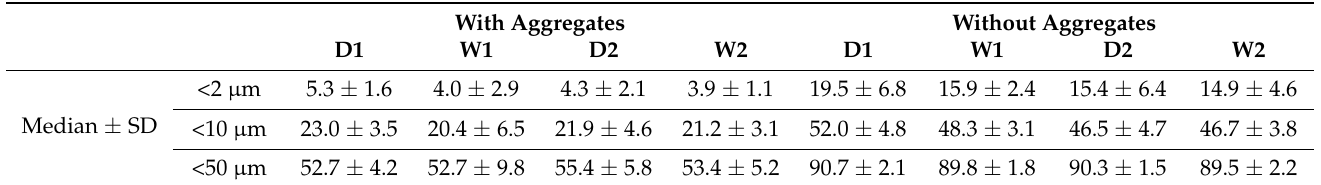
Table 5. Statistical analysis (median and standard deviation) of influence of initial conditions to the particle size distribution (obtained by LD) for the samples from the plot with slope 34 ◦ [%]. With Aggregates Without Aggregates D1